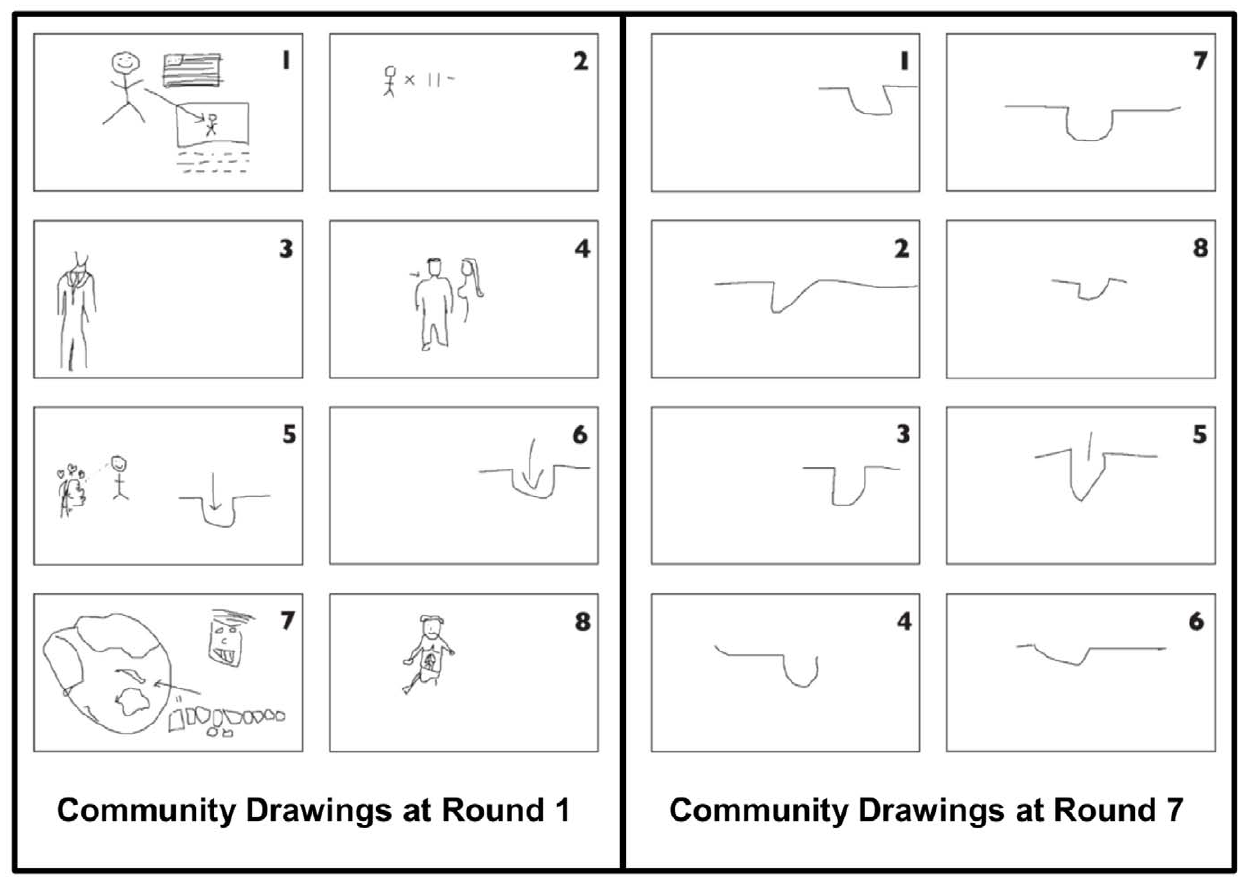
Figure 1. Example drawings of the concept ‘‘Brad Pitt’’ from one of Fay et al.’s (2010) ‘‘communities’’. Individual participant numbers are given in the top right of each drawing. On each round, participants were paired with a new partner, with whom they played a total of six games, each involving the same set of list items. There were eight participants in each community. Reprinted with permission from [10, p363, Figure 2].